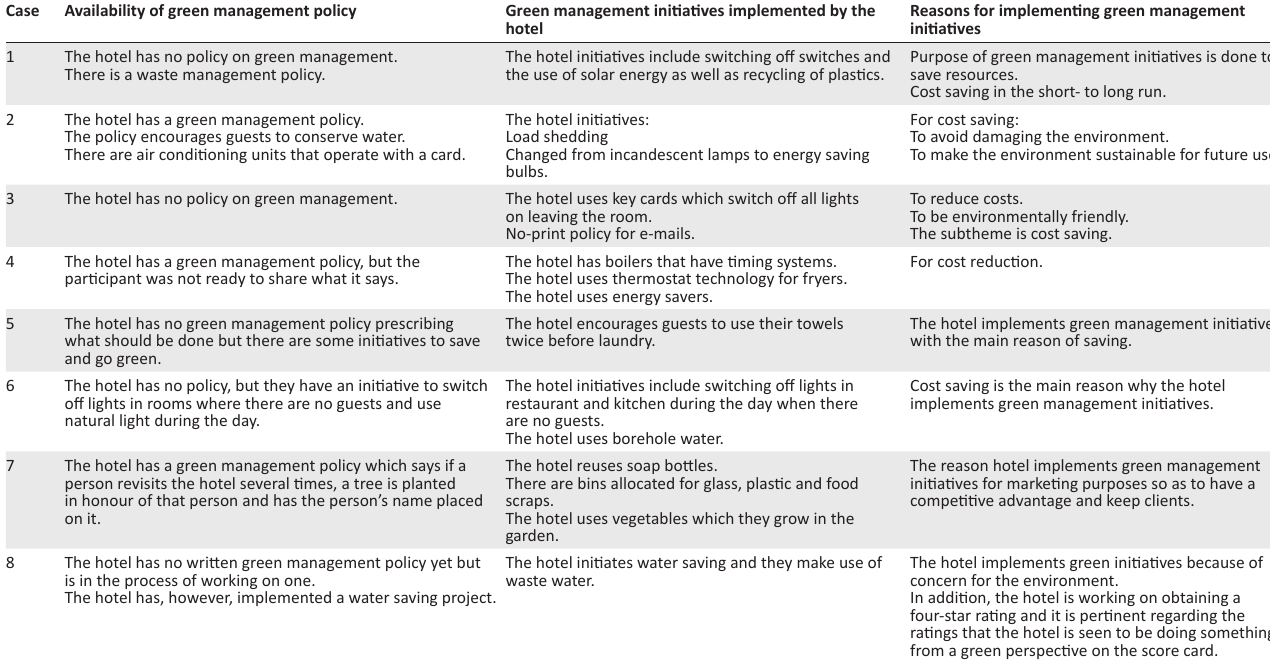
TABLE 2: Summary of green management initiatives in hotel cases 1–8.